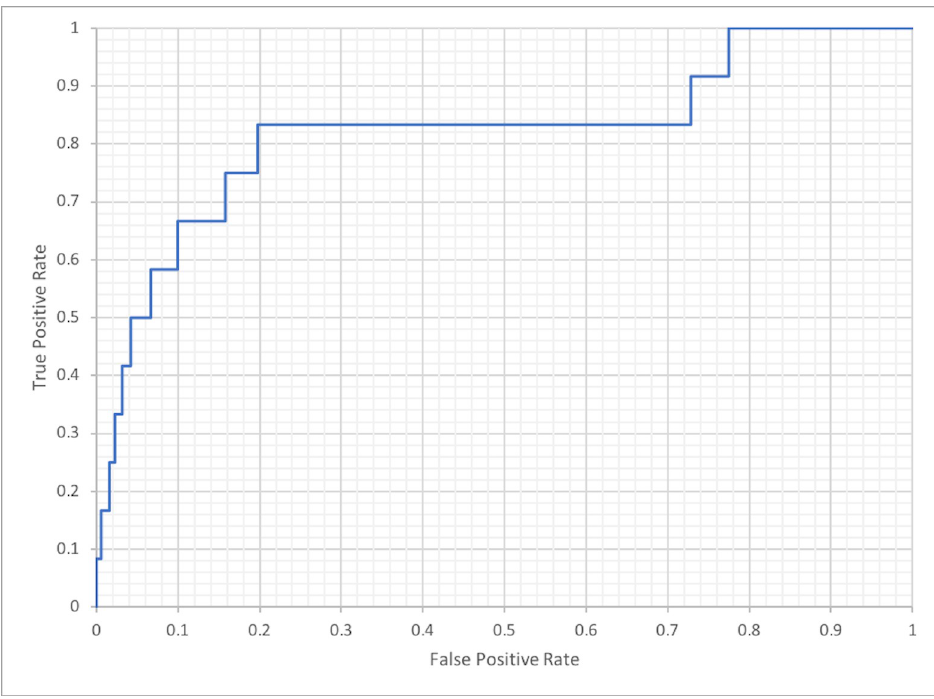
Fig 2. Receiver operating characteristic curve of WDD-predicted versus known BTK interactions. Resulting receiver operating characteristic curve from analysis comparing WDD-predicted BTK biomarker ranking to a subject matter expert-derived list of potential BTK biomarkers. Area under the curve = 0.82.